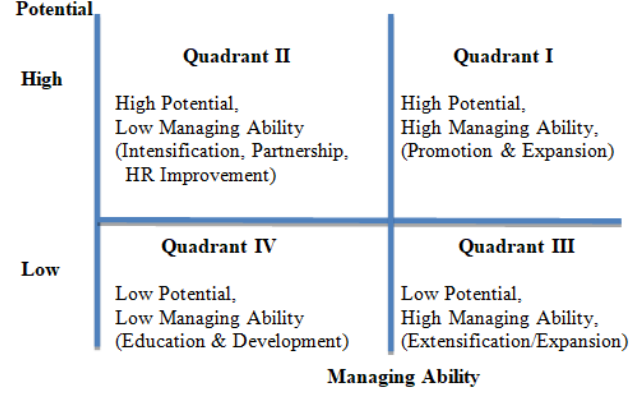
Figure 1: Regional Potential; Source: (Mahmudi,